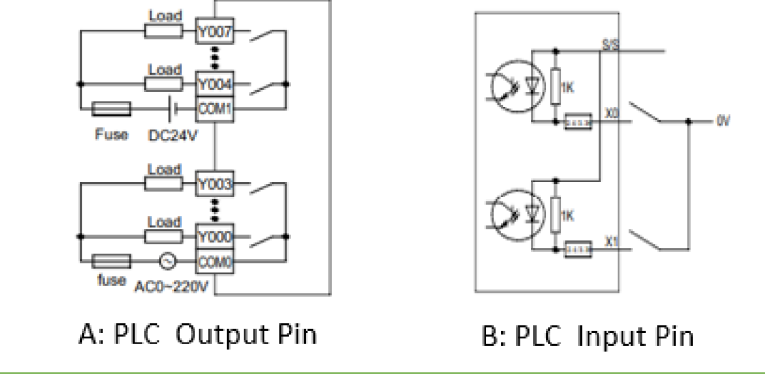
Figure 6. Electrical wiring of PLC input and output